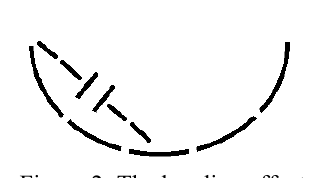
Figure 2: The bending effect. 3. The wave in the elliptical coordinate Picture 3 shows the elliptical coordinate.